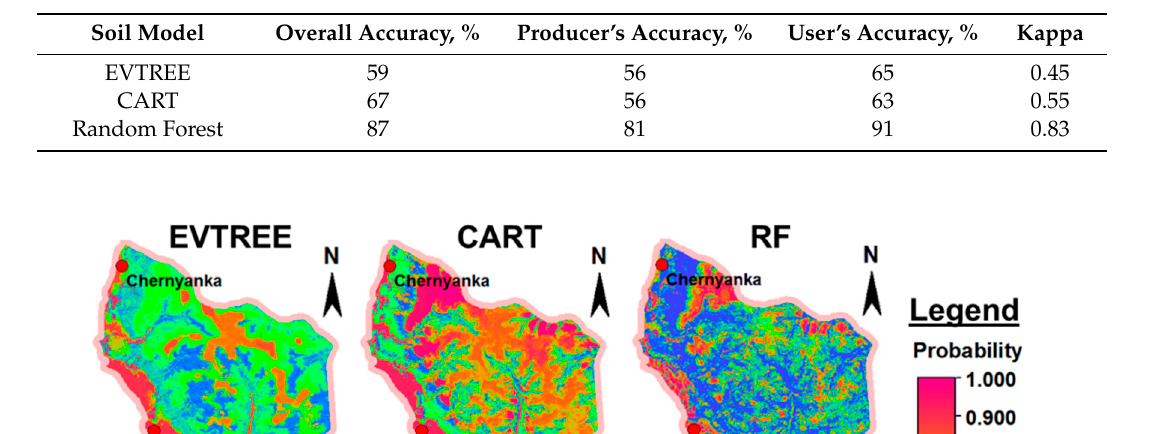
Figure 8. Probability maps of the most likely soil class created using three methods: EVTREE (stochastic), CART (stochastic), and Random Forest.